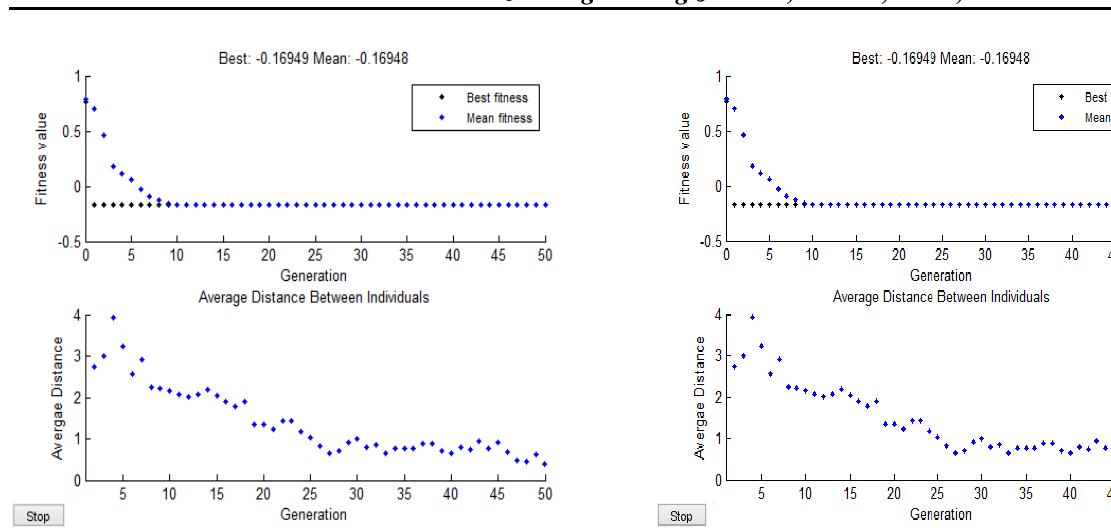
output of circular >